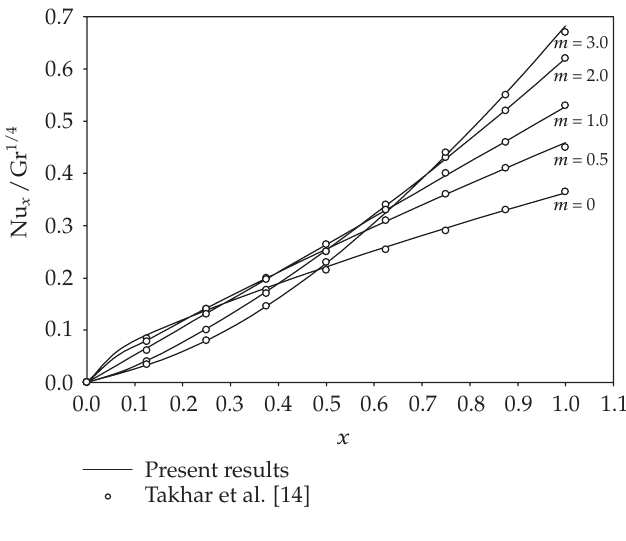
Figure 5.10 . Comparison of local Nusselt number.